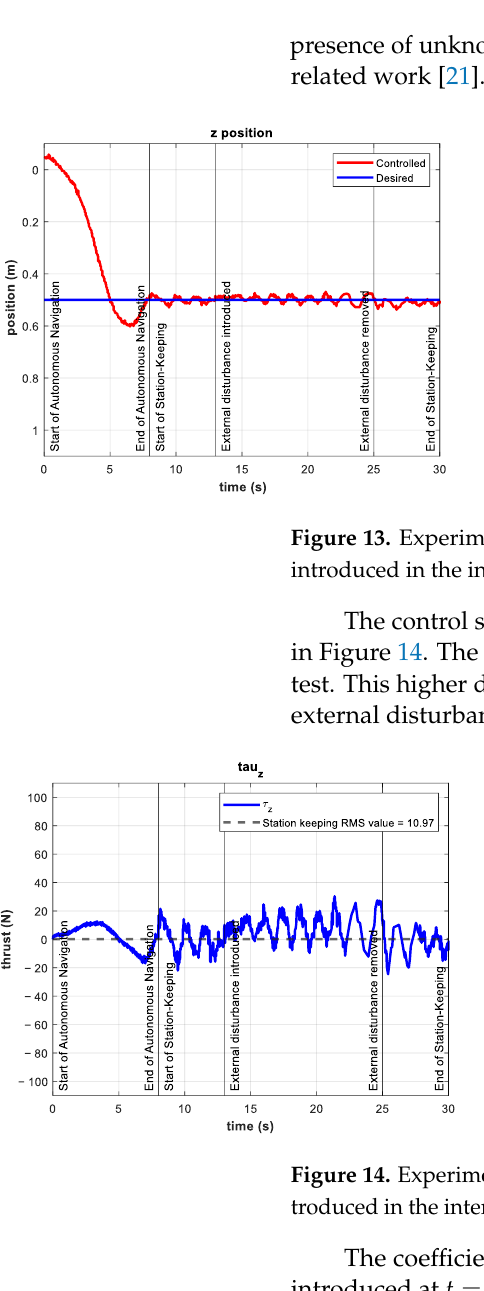
introduced at t = 13 s and maintained until t = 25 s.